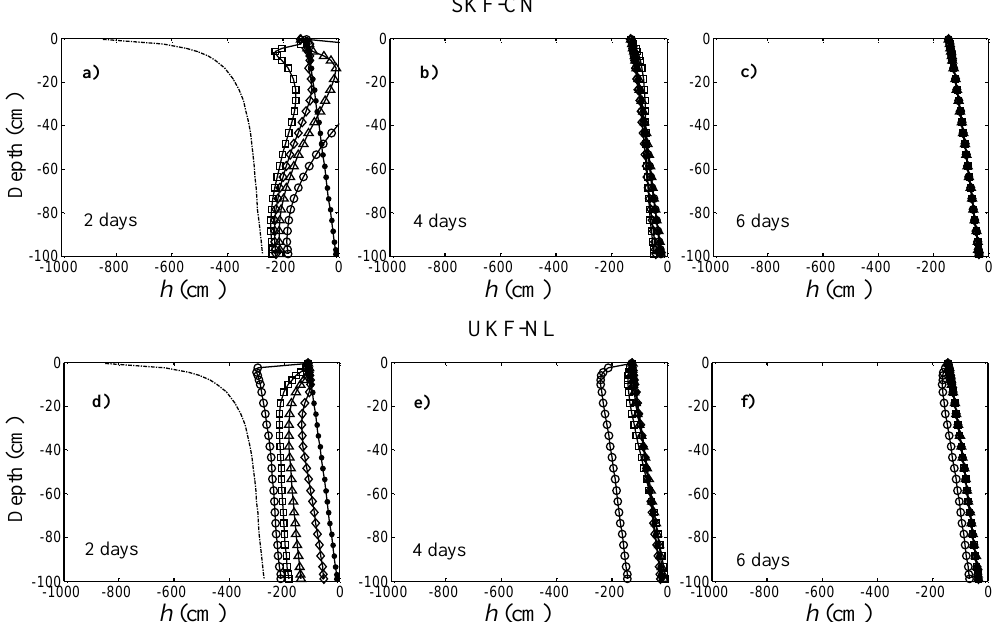
Figure 4. Retrieved profiles after (a, d) 2 days; (b, e) 4 days, and (c, f) 6 days using SKF-CN and UKF-NL, respectively, by assimilating matric pressure head observations every two days involving the nodes within the top 0.5cm (open circle), 1.5cm (square), 4.5cm (triangle) and 10.5cm (diamond), as compared with the “true” profile (closed circle) and “guess” profile (dashed line).